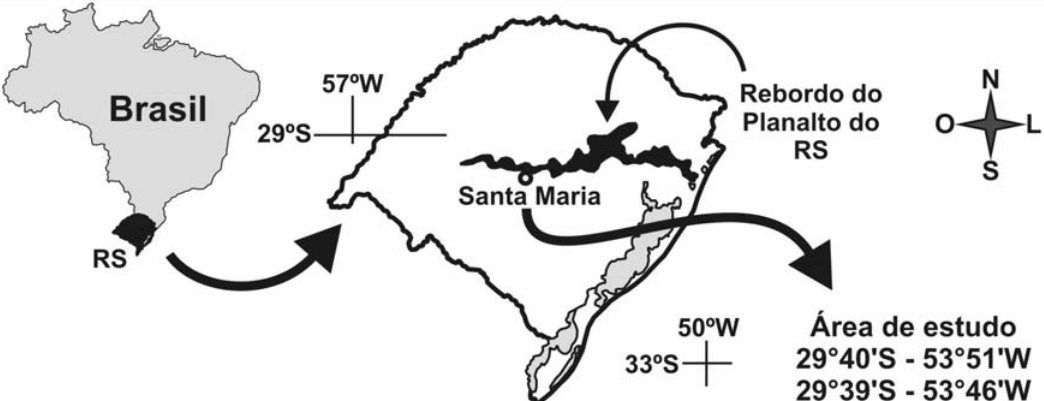
Figura 1. Localização da região de estudo, onde foram amostrados perfis de Neossolos Litólicos e Regolíticos derivados do arenito da Formação Caturrita no